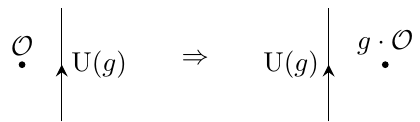
Figure 1. The symmetry operator U( g ) for an element g of the symmetry group G causes the symmetry action on a local operator when the symmetry operator passes through the local